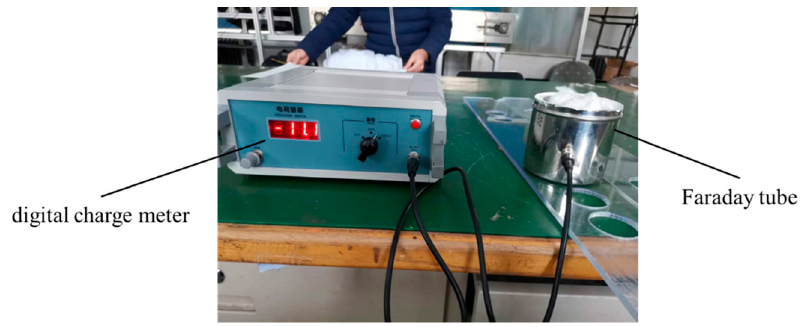
Figure 4. Material charge test device.